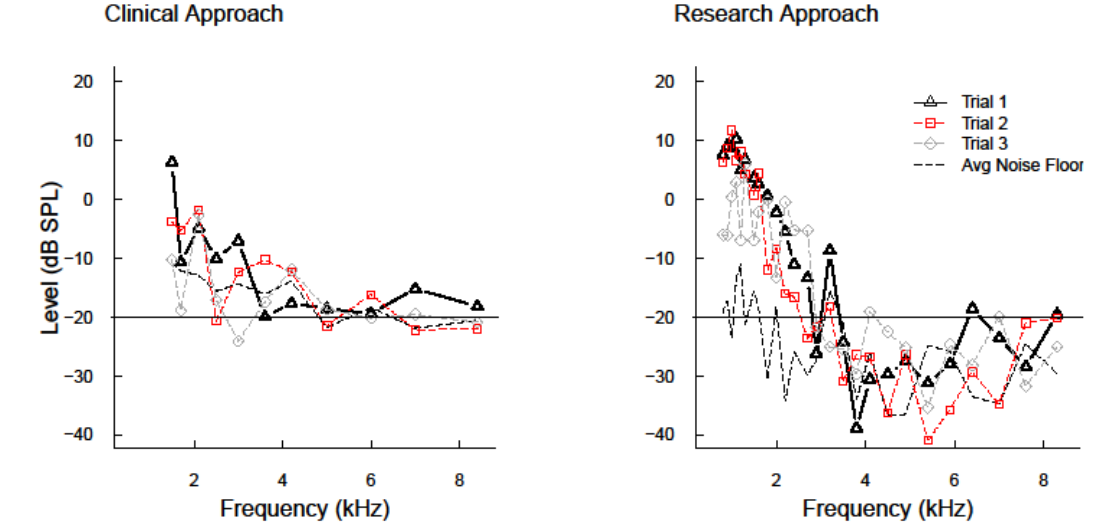
Figure 5. Case illustration of an adult undergoing cisplatin therapy with serial measurement of DPOAEs over 3 trials, averaging 3 weeks apart displayed. DPOAE levels across f 2 frequencies (up to 8 kHz) using standard stimulus parameters (1.22; 65 / 55 dB SPL) tested using a clinical approach ( left panel ; SPL calibration; ~4 points per octave) and research approach ( right panel ; FPL calibration; ~8 points per octave). The solid lines with black triangles represent trial 1 (baseline) prior to exposures and the long-dashed lines with red squares or gray diamonds represent trials 2 and 3 (monitoring visits), respectively. The short-dashed lines without symbols are the average noise floor for all trials for the respective approach. The line at − 20 dB SPL plotted as a reference for visual comparison.